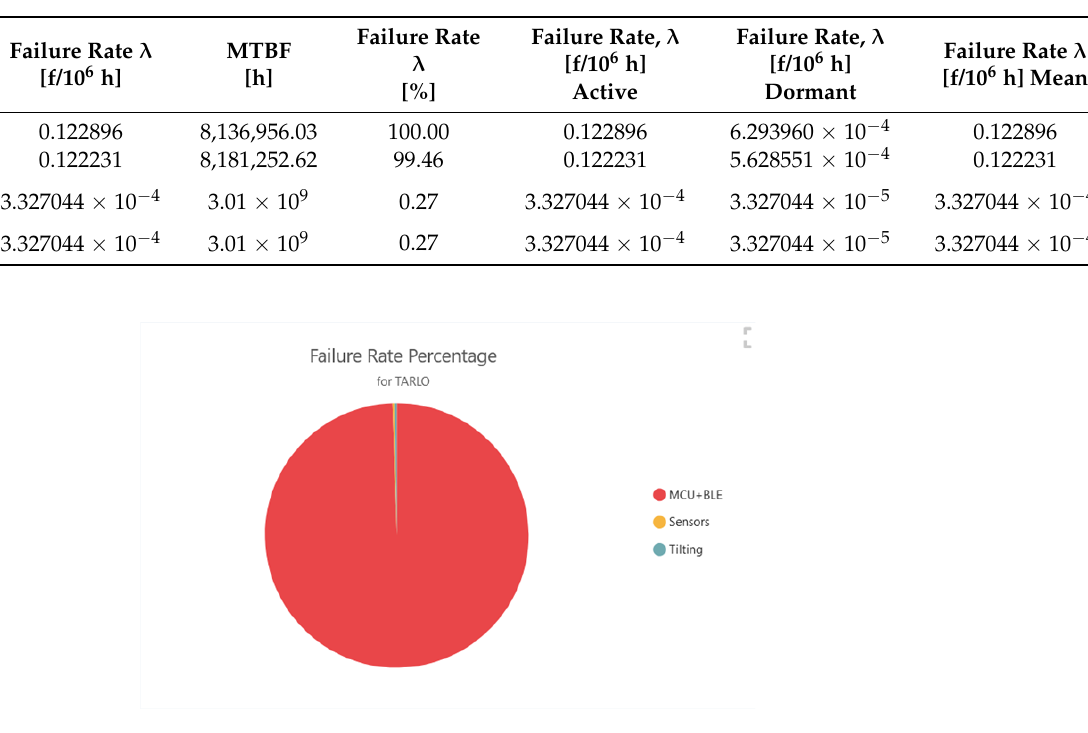
Table 1. Reliability analysis of the sensor node structure considering all the blocks working 100% of the mission for continuous operating mode in GB and 25 ◦ C.